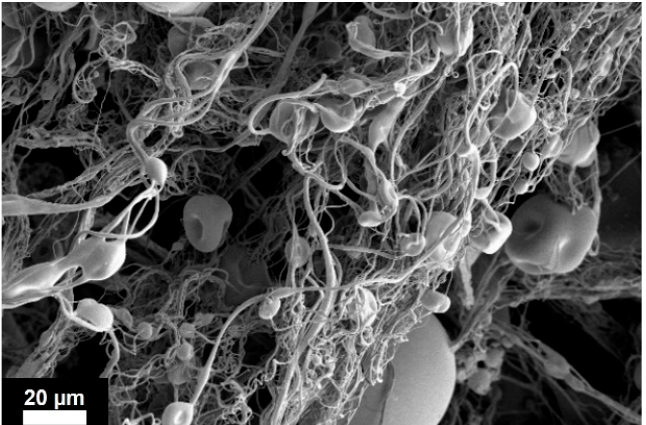
Figure 5. SEM image of 5% w / w PLGA fibers/particles obtained from the solid residue produced at 140 bar. Applied voltage 30 kV. Scale bar 20 µm.